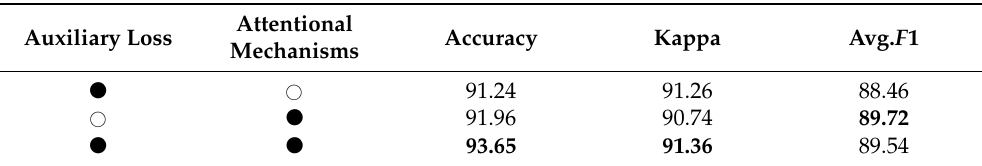
Table 7. Ablation study of loss functions and attention mechanisms. The best results are highlighted in bold (Area_1).